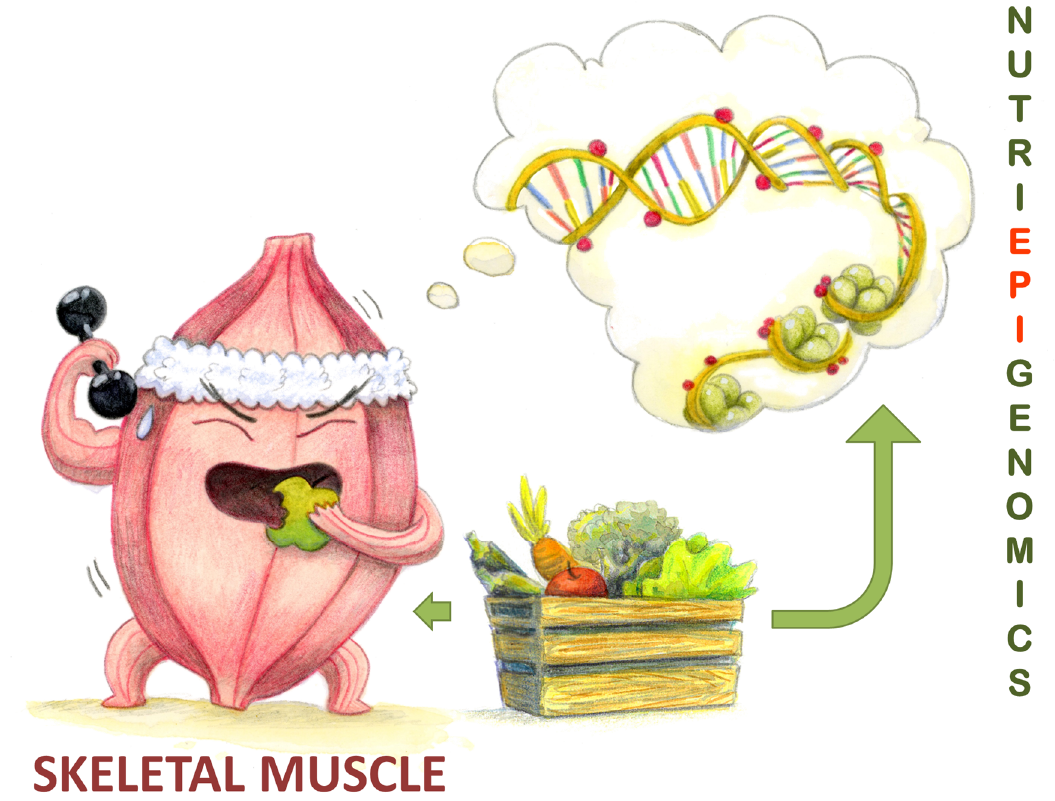
Figure 1. Nutritional status and epigenetic memory a ff ect muscle response to physical activity. Nutri(epi)genomics modulates physical performance a ff ecting skeletal muscle trophism and its response to external stimuli, by modulating numerous molecular pathways through epigenetic regulations